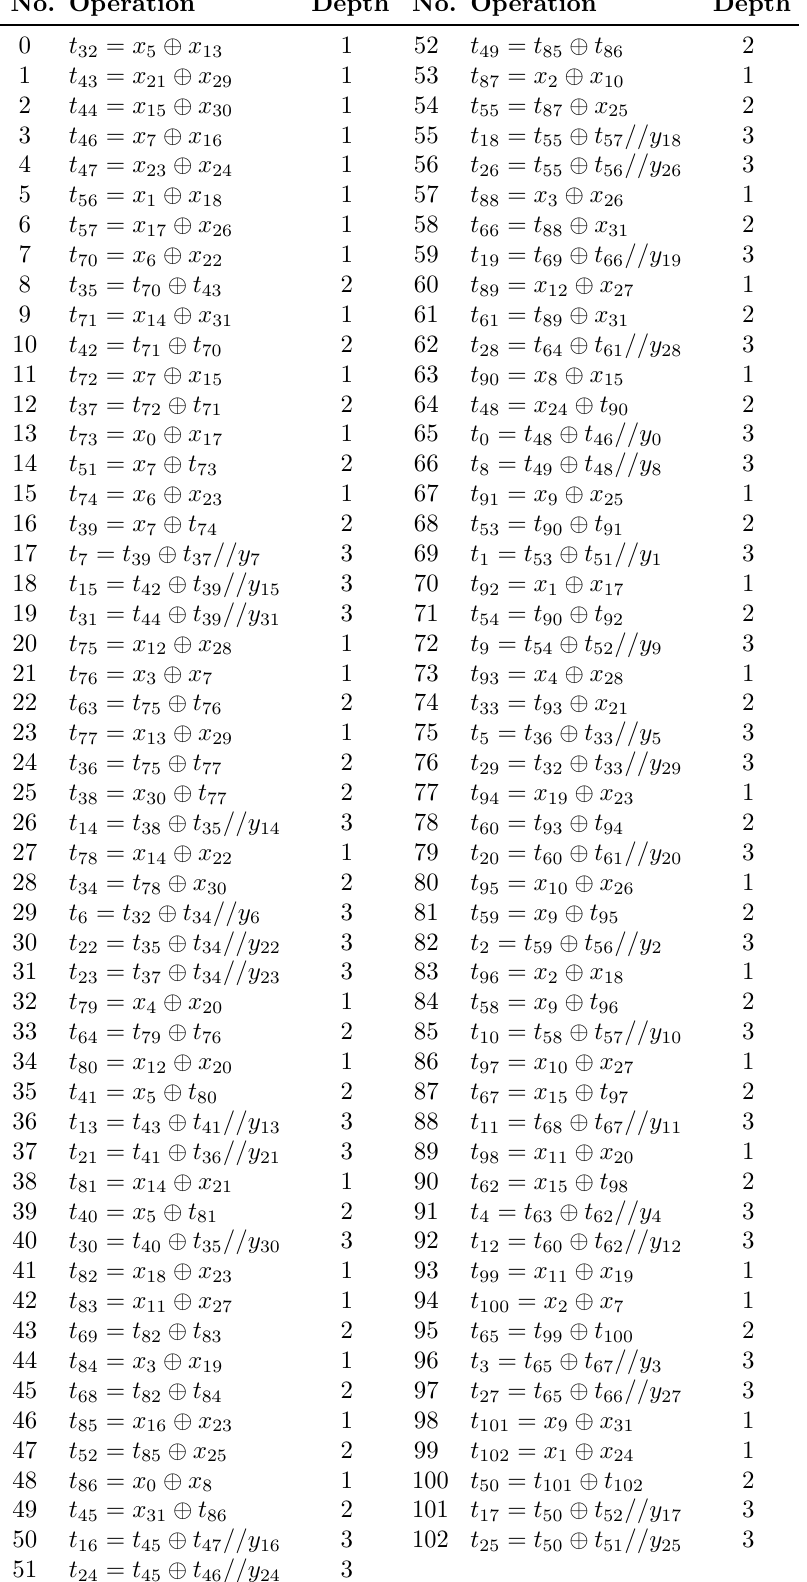
Table 7: An implementation of AES MixColumns with 103 XOR operations No.